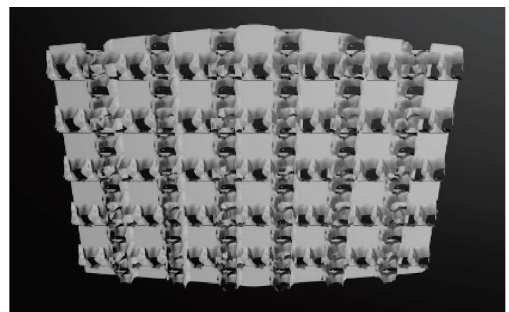
Figure 5: Laser structured base design.